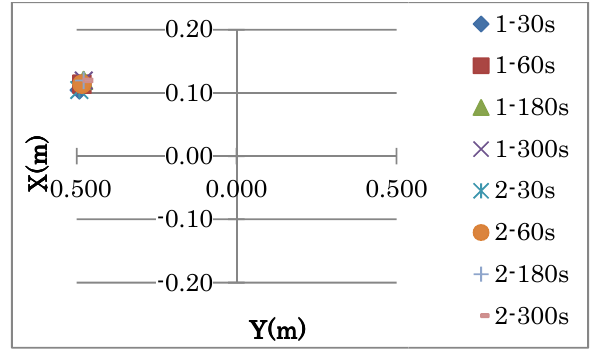
Figure 11. Observation results of LEX signal (Fixed Point) Fixed-position